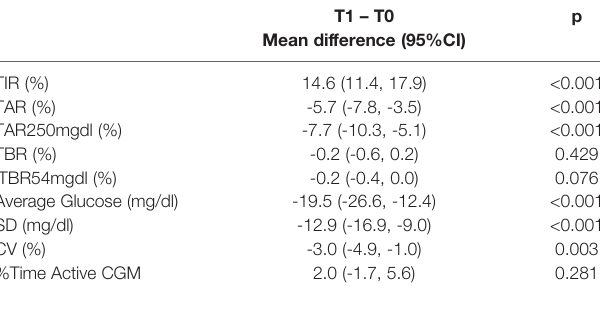
TABLE 2 | Summary of overall treatment effect.